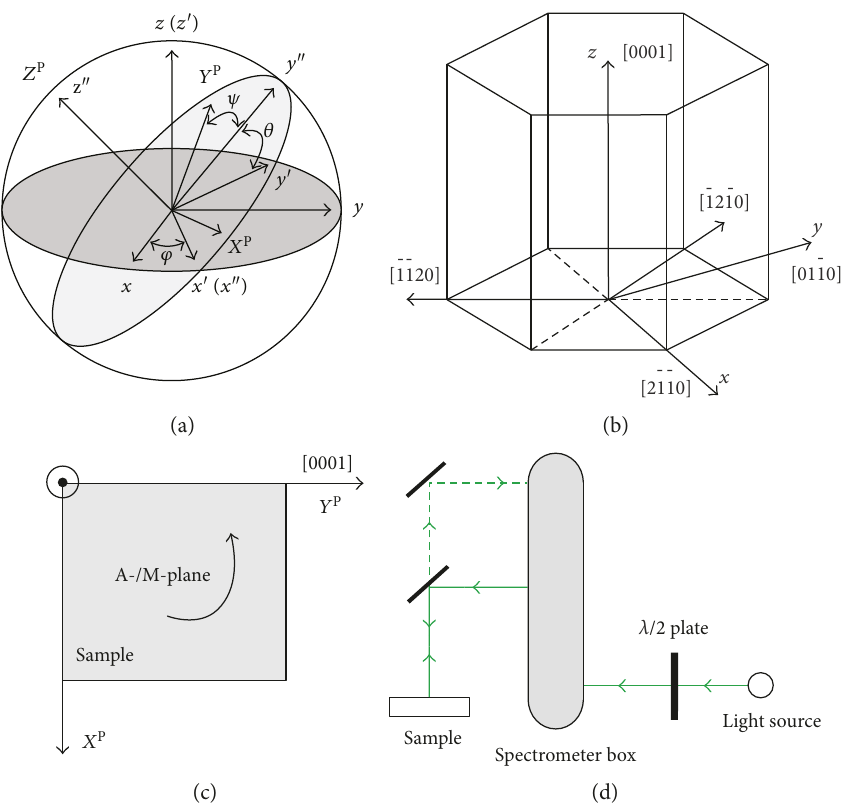
Figure 1: (a) The relationship between specimen coordinate system and crystal coordinate system; (b) the relationship between the hexagonal coordinates and Cartesian coordinates for wurtzitic crystal; (c) A-/M-plane ZnO sample initial position; (d) optical path in the Euler angle measurement